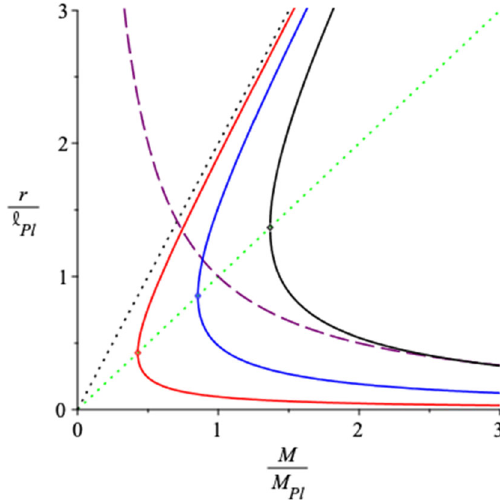
Fig. 3 The solid curves show the outer and inner horizons for a stan- dardRNblackholewith n = 5 , 11 , 16(lefttoright).Foreach n ,thehori- zons meet at the extremal mass on the line r = M / M 2 andareboundedfromabovebytheSchwarzschildradius r S = 2 M / M 2 (black dotted line). The Compton curve is shown by the dashed line and the inner horizon asymptotes to this for n = 16. Solutions with n < 11 penetrate the sub-Planckian RN regime and are discussed in Sect.